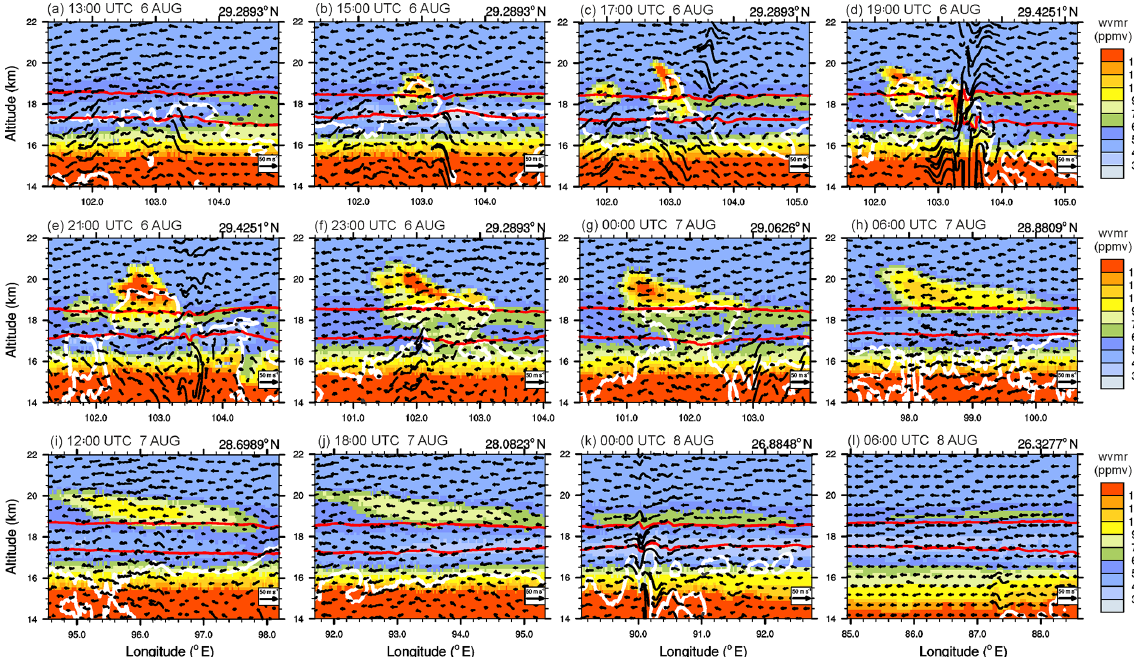
Figure 6. Vertical cross sections of water vapour mixing ratio (wvmr) (shading) and wind (vectors) at (a) 13:00UTC, (b) 15:00UTC, (c) 17:00UTC, (d) 19:00UTC, (e) 21:00UTC, and (f) 23:00UTC on 6 August 2017; (g) 00:00UTC, (h) 06:00UTC, (i) 12:00UTC, and (j) 18:00UTC on 7 August 2017; and (k) 00:00 UTC and (l) 06:00UTC on 8 August 2017. The isentropic altitudes of 380 and 410K are depicted by the red lines. The latitude ( ◦ N) of west–east-oriented cross-section line is indicated at the upper right of each panel. The cloud boundary (mixing ratio of ice content of 10mgkg − 1 ) is contoured by the white solid line.